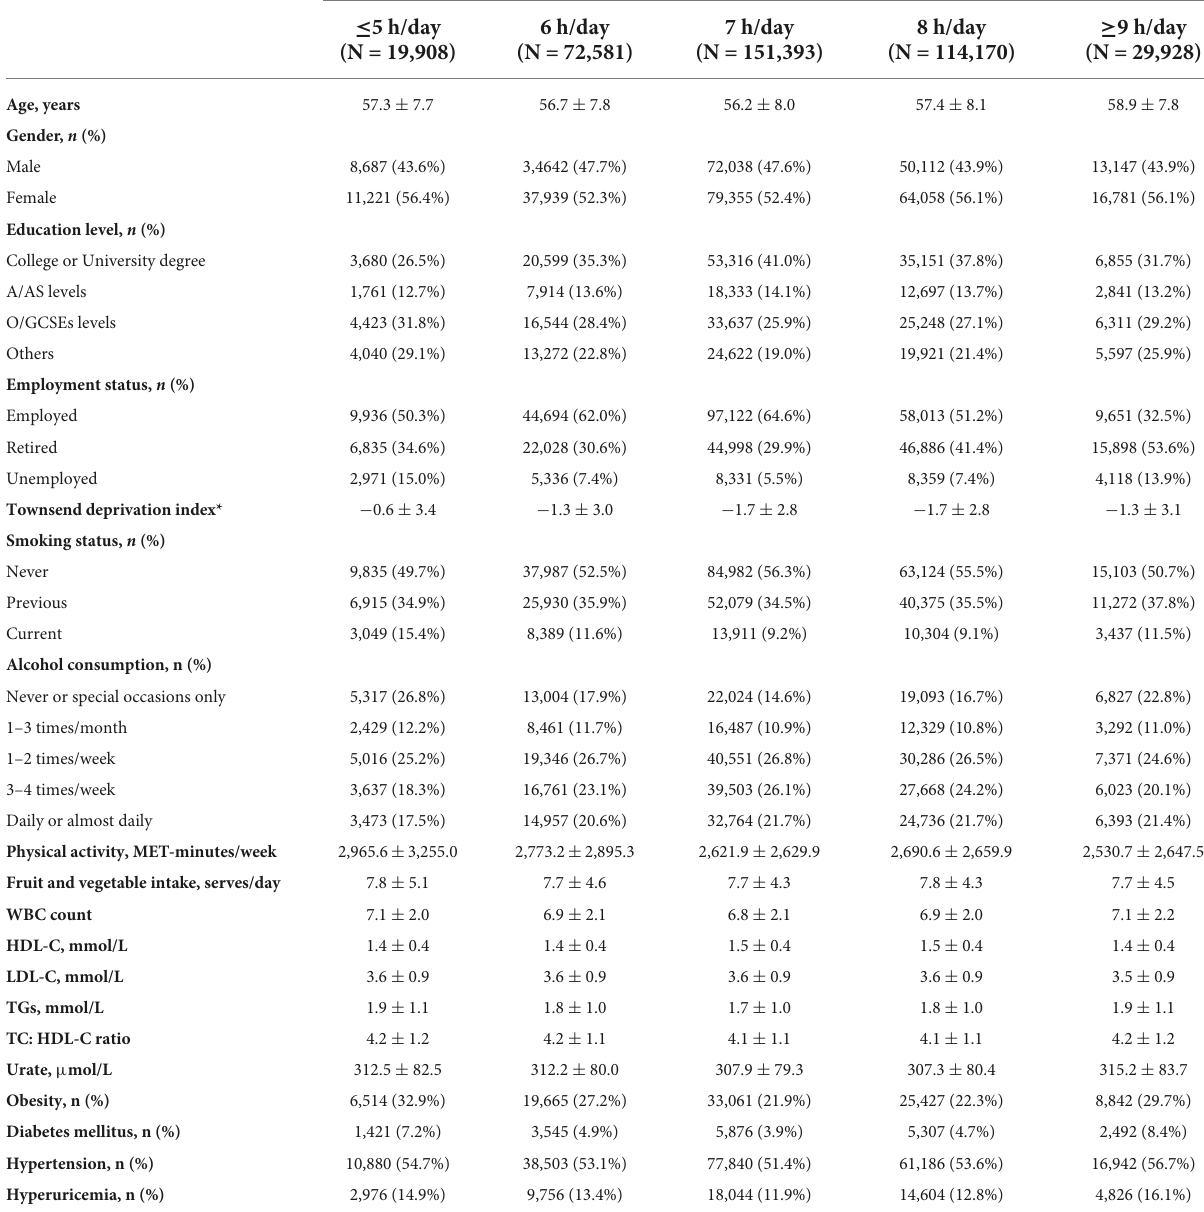
TABLE 1 The characteristics of study participants across categories of sleep duration.